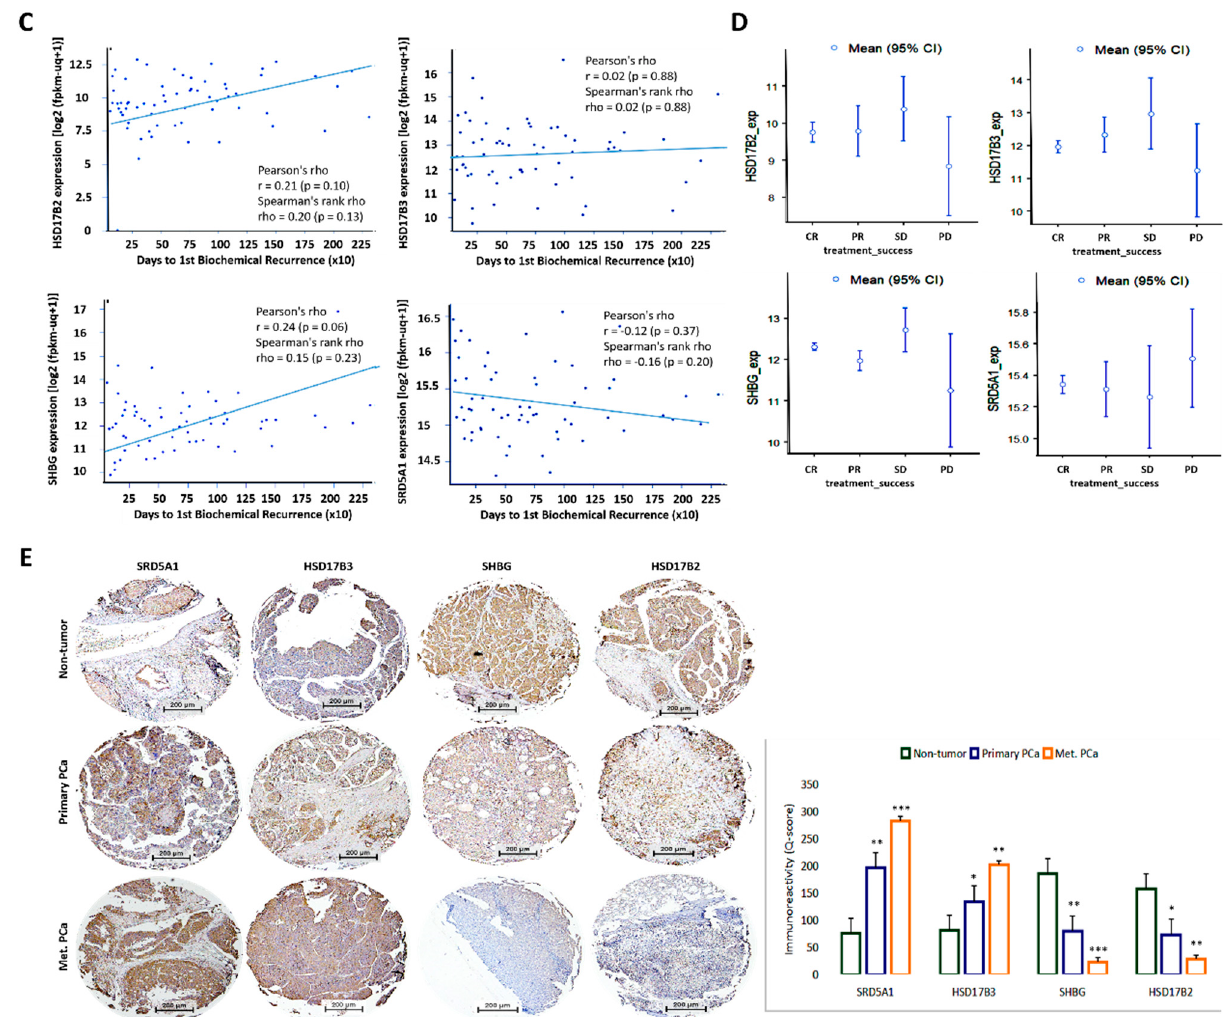
Figure 3. The differential but concerted expression of HSD17B2, HSD17B3, SHBG, and SRD5A1 is associated with the metastatic and recurrent phenotype of patients with PCa. Graphical representation of the association between HSD17B2, HSD17B3, SHBG, or SRD5A1 mRNA expression level and ( A ) clinical M stage, ( B ) biochemical recurrence status, ( C ) number of days to biochemical recurrence, and ( D ) treatment success, in the GDC TCGA PRAD cohort. ( E ) Representative photo ‐ images and histograms of SRD5A1, HSD17B3, SHBG, or HSD17B2 protein expression level in adjacent nontumor prostate, primary, or metastatic samples from the SHH PCa cohort. M, metastasis; exp, expression; CI, confidence interval; GDC, genomic data commons; SHH, Shuang Ho Hospital; *, p < 0.05; **, p < 0.01; ***, p <